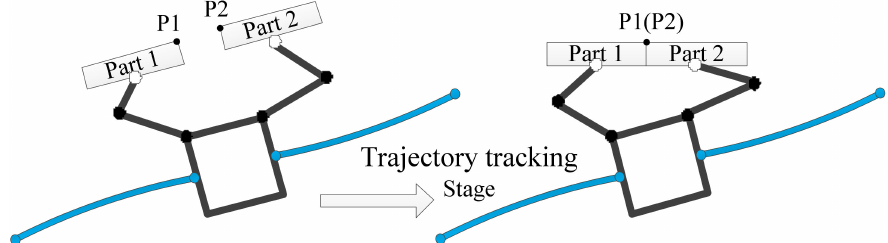
Figure 6. Trajectory tracking stage for the final